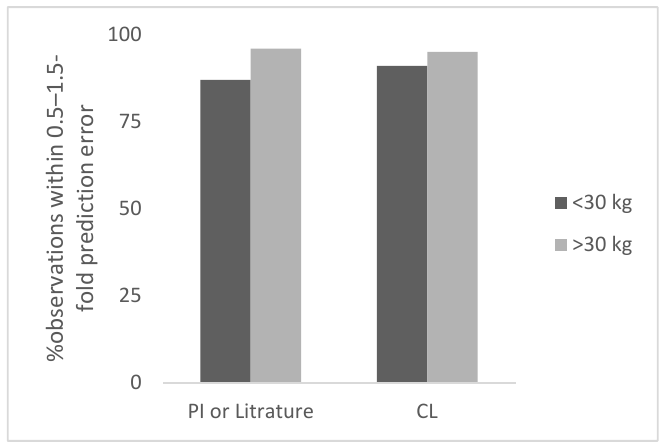
Figure 1. Percent observation within 0.5–1.5 ‐ fold prediction error for monoclonal antibodies.